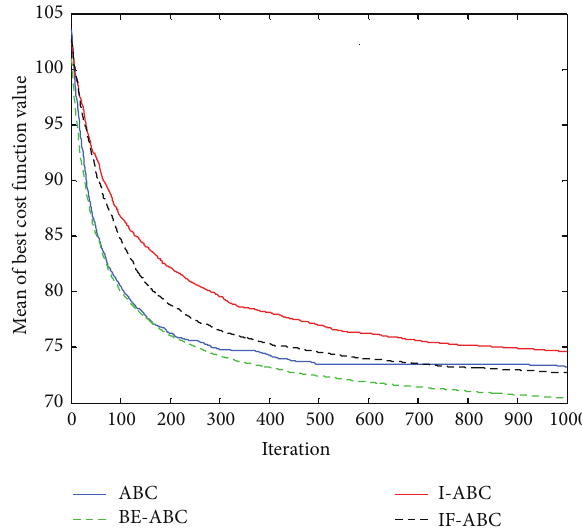
Figure 10: Comparative convergence curves of ABC, I-ABC, IF- ABC, and BE-ABC in Case 3 ( 𝐷 = 30 and MCN = 1000